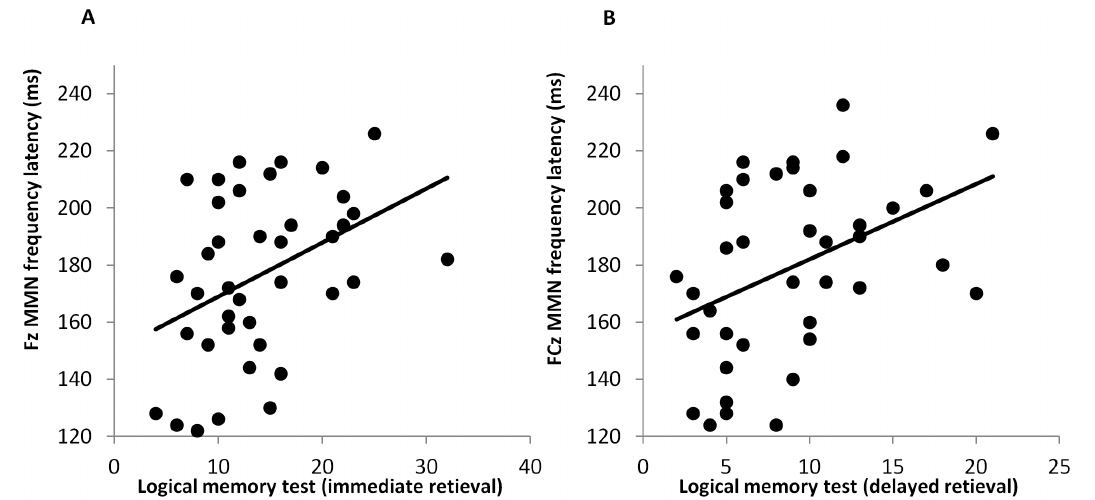
Figure 4. Linear associations between MMN latency and patient’s verbal memory performance. Scatterplots of immediate (A) and delayed (B) verbal memory performance score against MMN amplitude to frequency deviants at Fz and FCz, respectively.